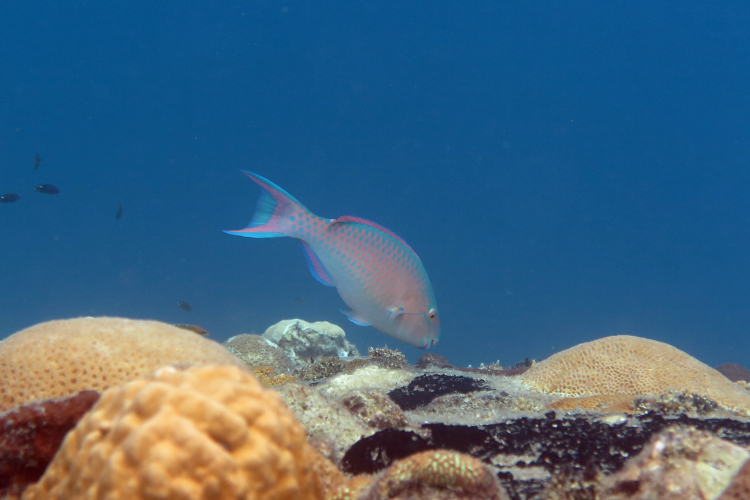
Scarus
caudofasciatus (male)